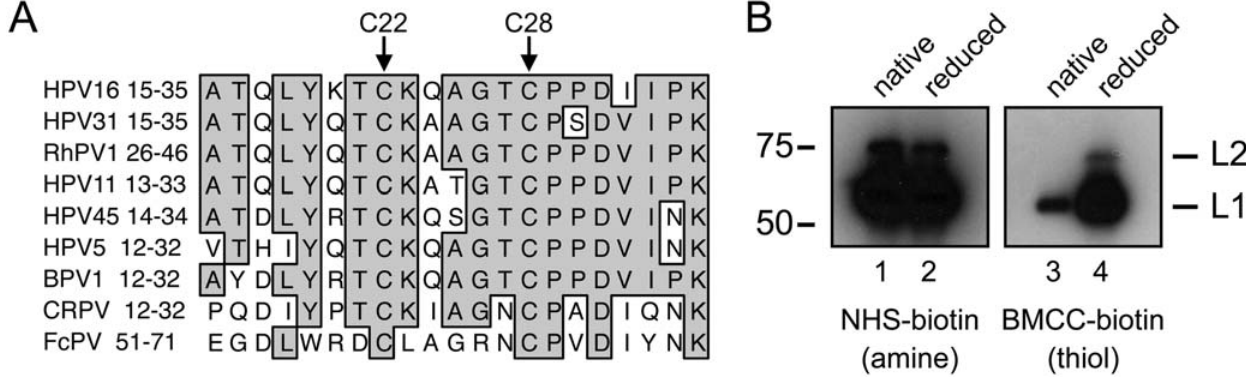
Figure 1. Highly conserved HPV16 L2 cysteines C22 and C28 are not reactive with BMCC-biotin in native virions. (A) Primary amino acid sequence alignment of L2 proteins from various members of the Family Papillomaviridae shows conservation of C22 and C28 (HPV16) across divergent genera . (B) Amine and thiol biotinylation assays of HPV16 virions. Purified virions were either mock treated (native) or DTT treated (reduced) prior to incubation with amine reactive NHS-biotin or thiol reactive BMCC-biotin. Biotinylated proteins were separated by SDS-PAGE, transferred to membranes, and detected with streptavidin-HRP. Note that L2 cysteines are only reactive when the virions are reduced prior to labeling.